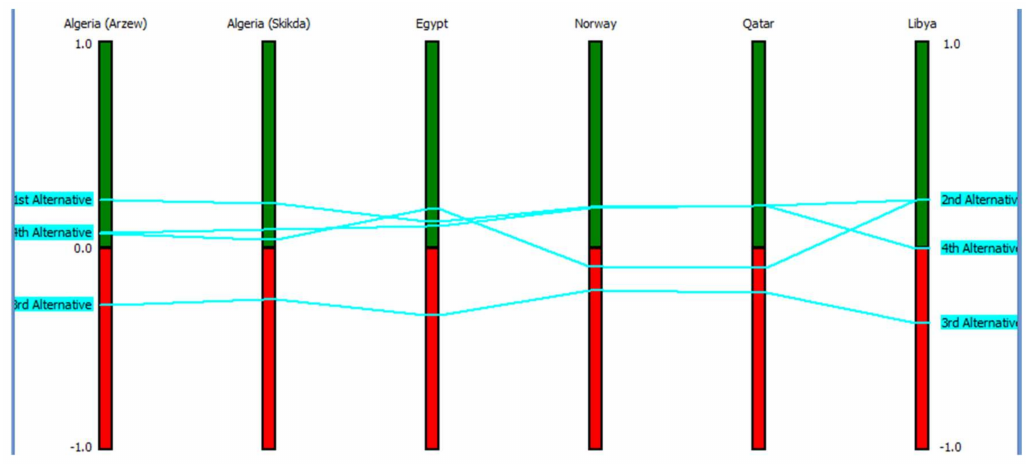
Figure 6. The results obtained from PROMETHEE II for the 2nd